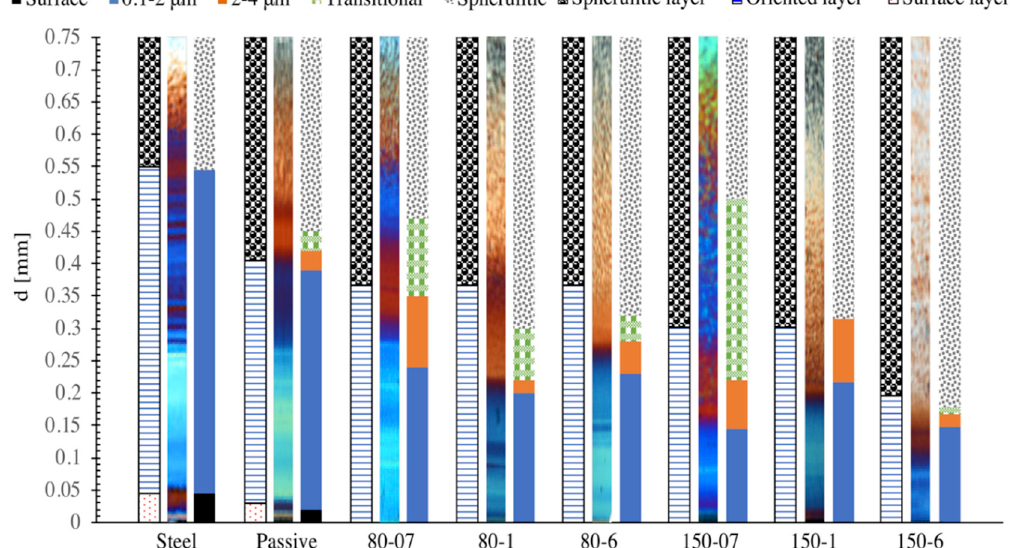
Figure 7. Comparison between experimental morphology distribution along the cross sections of the injection molded samples under the conditions listed in Table 1. Three bars are reported for each of the injection conditions, all of them refer to the morphology distribution in position P2: the central bar is the optical cross section micrograph; the bar on the left reports the predictions of the criterion adopted in this paper for the thicknesses of the surface layer, when present, of the oriented morphological layer and of the spherulitic layer; the bar on the right reports the width and characteristics of the morphological layers as detected using AFM analysis reported in [20]. Each color of the bar on the right corresponds to the thickness of the morphological elements as specified in the legend.